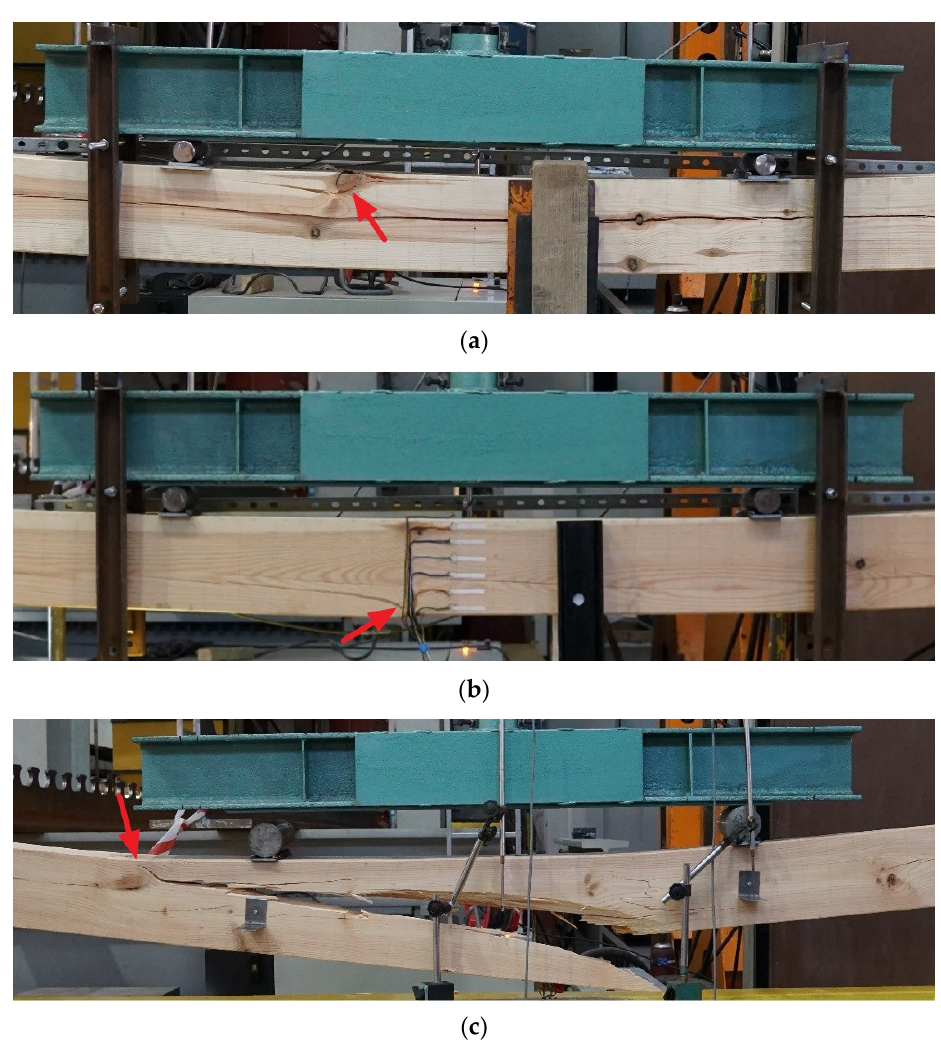
Figure 15. Defects indicated according to ASTM D245 [44] and potentially determining the load- bearing capacity of the beams: ( a ) beam A01-damage initiation caused by crushing of compressed fibers in the corner knot area (compression near knot [52]), ( b ) beam A02-damage initiation caused by rupture of tensioned fibers near the corner knot and slope of grain (cross grain tension/diagonal tension [33,52]) ( c ) beam A03-damage initiation caused by crushing of compressed fibers in corner knot area (cross grain tension/diagonal tension caused by compression near knot [33,52]).